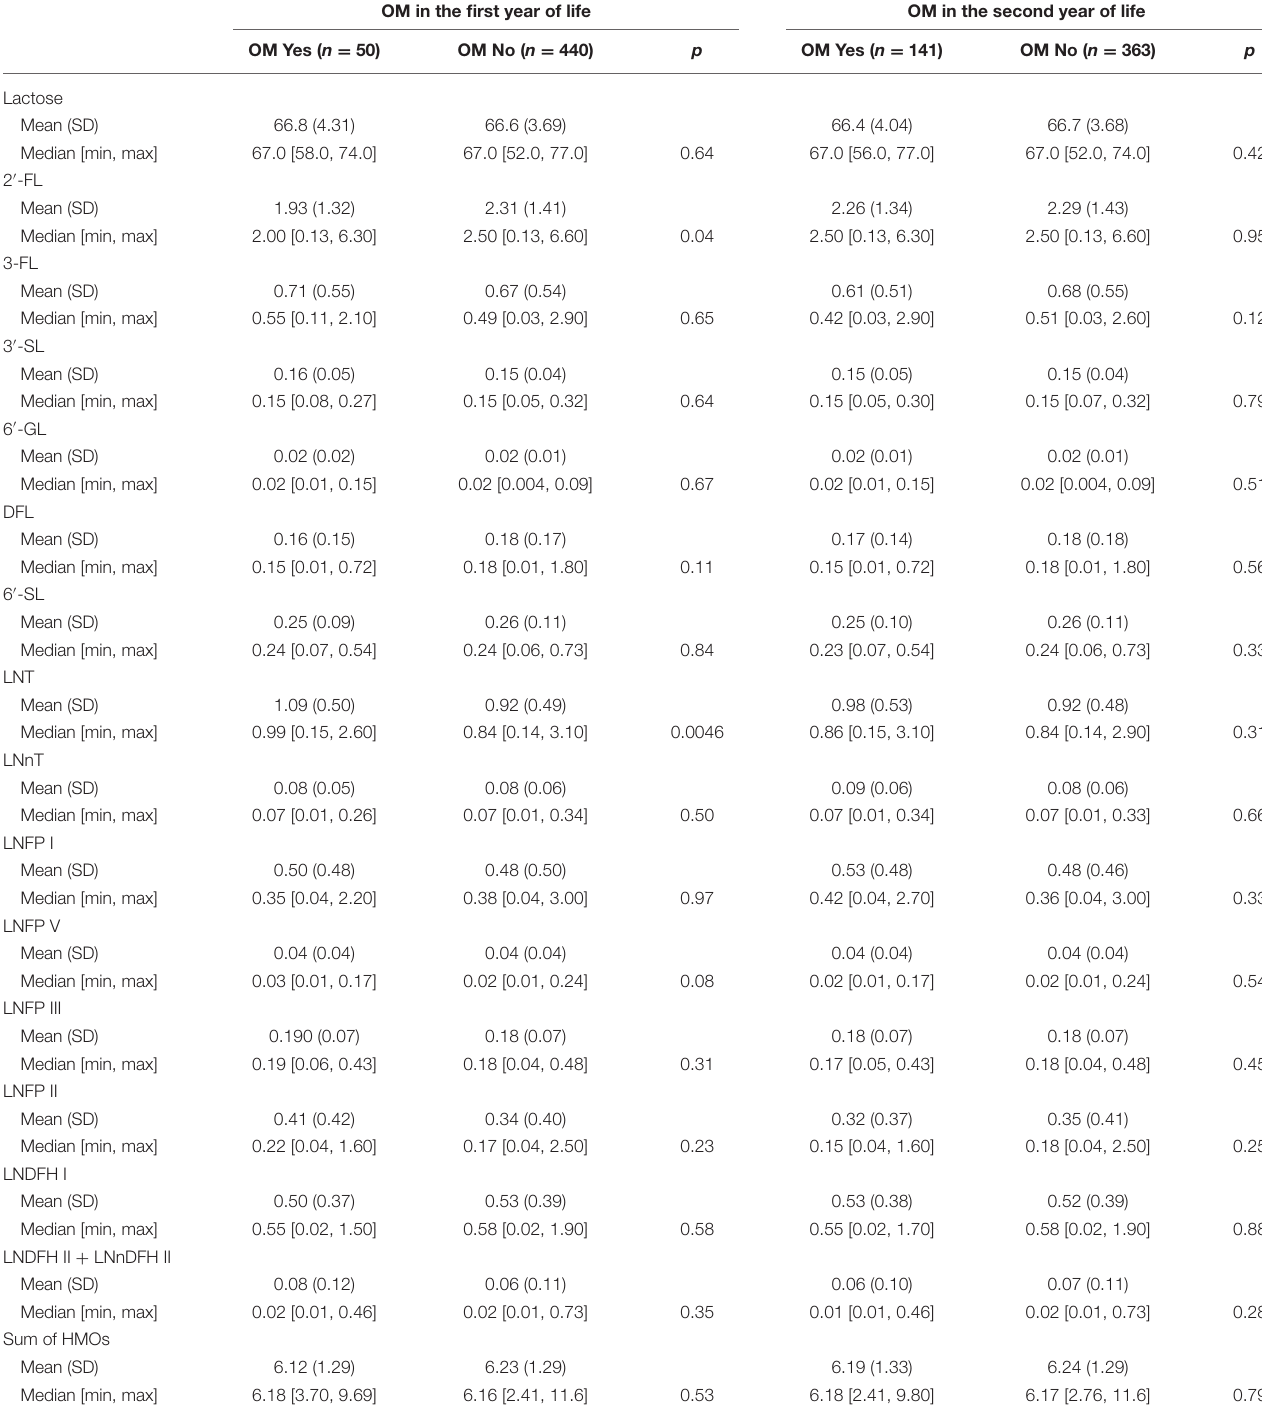
TABLE 3 | Absolute human milk oligosaccharide concentrations (g/L) measured at 6 weeks and otitis media in infants in the first or second year of life in the Ulm SPATZ Health Study. OM in the first year of life OM in the second year of